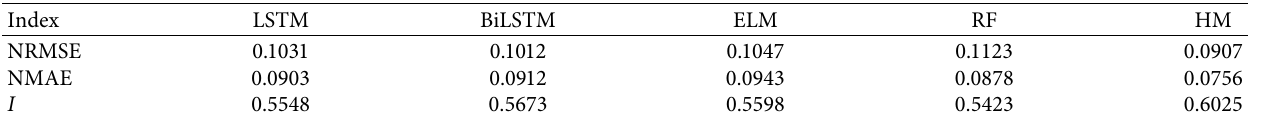
Figure 9: Limitation analysis of the HM model when the accuracy of WS correction is insufcient: (a) power prediction curve and (b) wind speed correction curve. Table 2: Te 16th step NRMSE comparison of HM and other